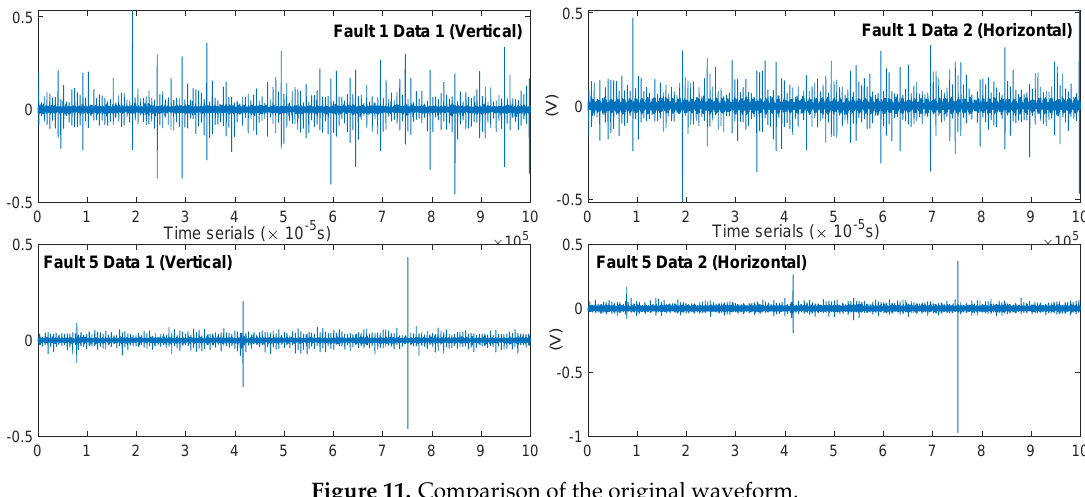
Figure 11. Comparison of the original